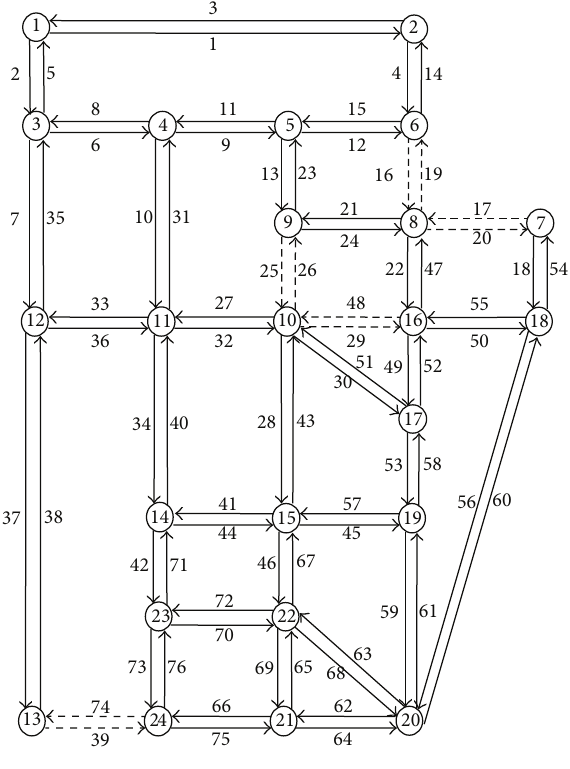
Figure 3: Sioux Falls